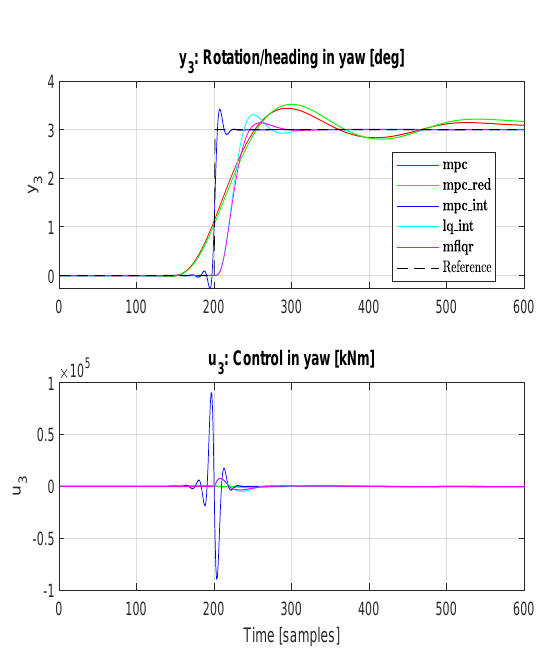
Figure 6: The figure shows the reference/setpoint step in yaw rotation/heading for the five different DP systems controller algorithms.